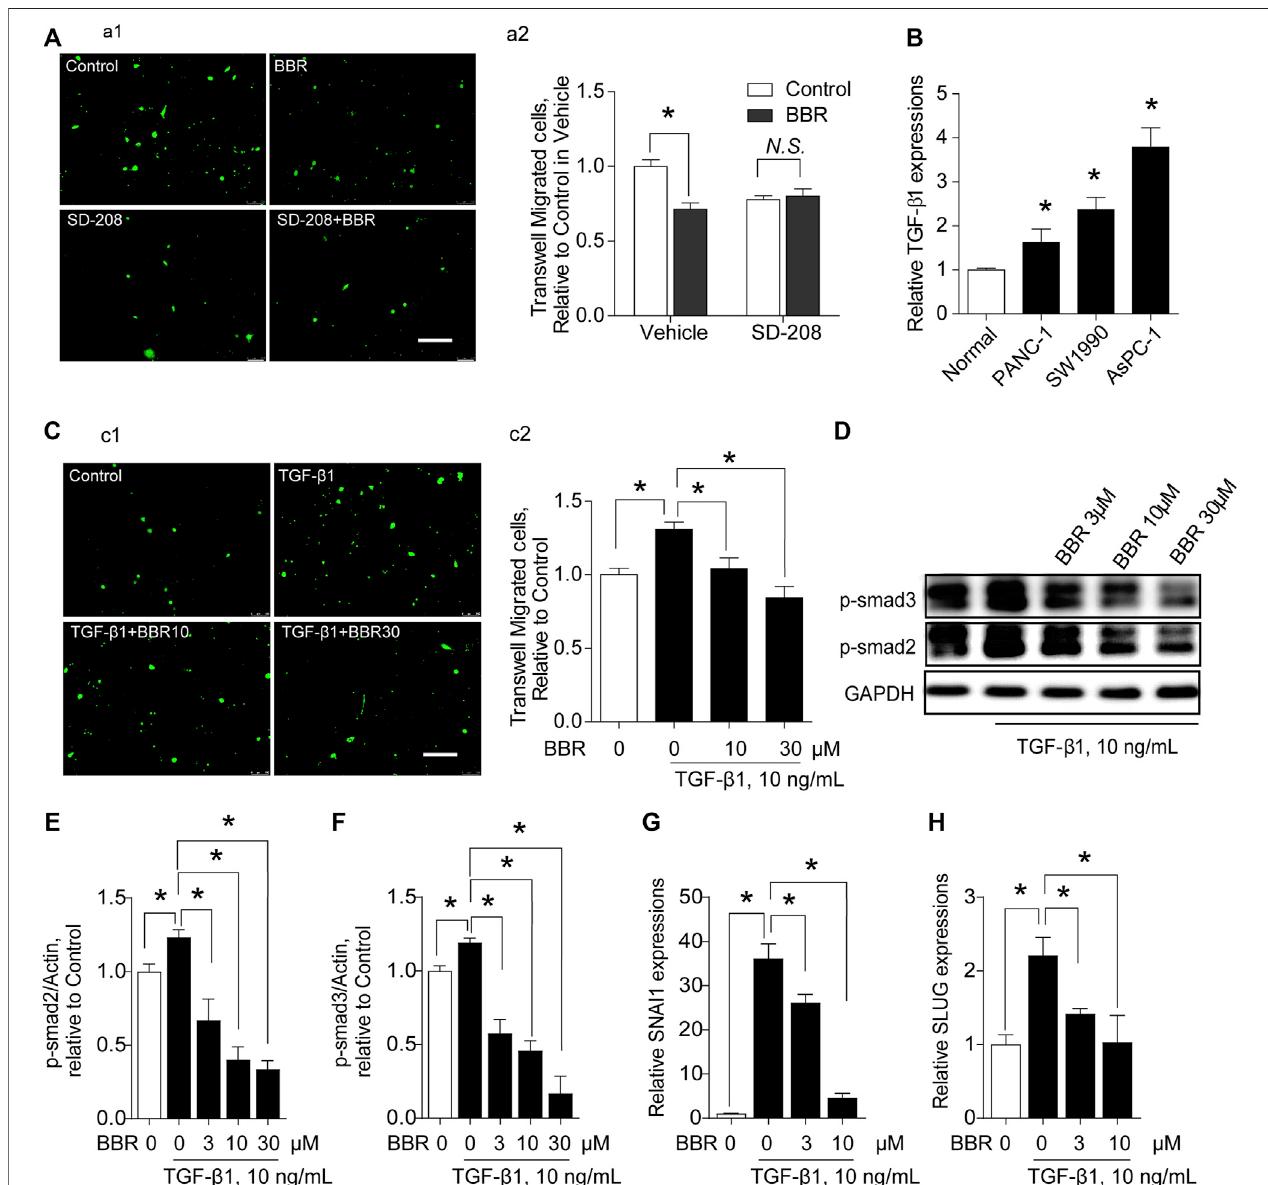
FIGURE 4 | BBR prevents trans-endothelial migration of pancreatic cancer cells in a TGFBR1-dependent manner. (A) Effect of TGFBR1 inhibition on the modulation of BBR in the trans-endothelial migration of AsPC-1 cells. (a1,a2) representative images and statistical results, respectively. n = 10 – 15. (B) . Production of TGF- β 1inPCcells(PANC-1,SW1990, AsPC-1). (C) .Effect ofBBRonTGF- β 1-triggeredtrans-endothelialmigrationofAsPC-1cells. (c1,c2) representative imagesand statistical results, respectively. n = 10 – 15. (D – F) . Representative western blot images (D) and statistical results (E,F) of the effect of BBR on TGF- β 1-induced phosphorylation of SMAD2/3 in ECs. n = 3 (G) . Effect of BBR on TGF- β 1-stimulated expression level of SNAI1 in ECs. n = 3 (H) . Effect of BBR on TGF- β 1-stimulated expression of SLUG in ECs. n = 3. * p < 0.05; one-way ANOVA with Bonferroni ’ s multiple comparison tests.